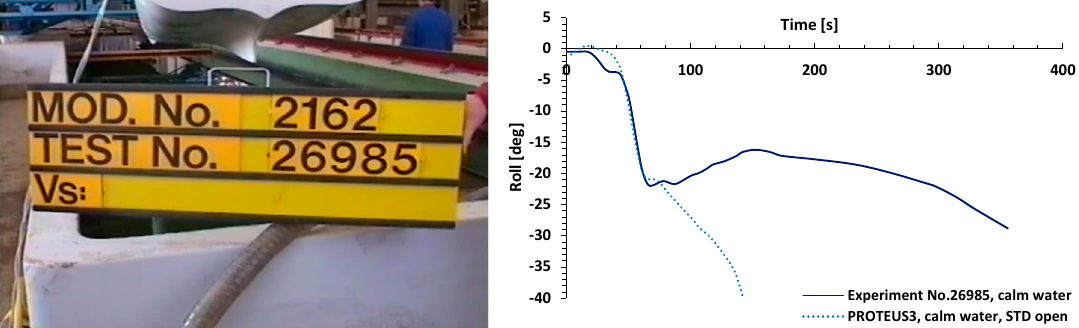
Figure 9. Typical transient loss modality distribution for a SOLAS’90 cruise ship (model experiment and numerical simulation results) .